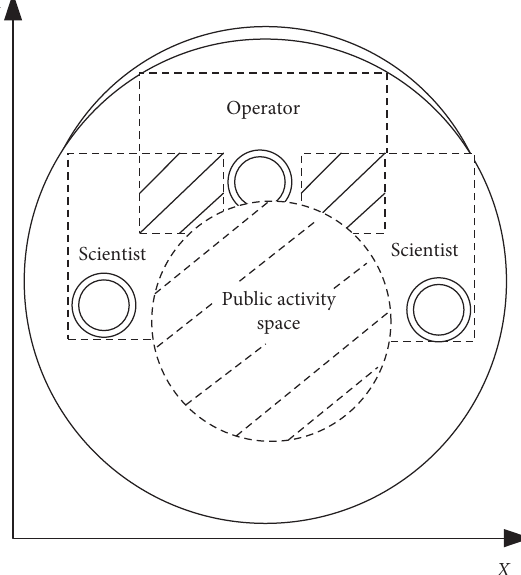
Figure 5: Reconstruction optimization of overlapping working areas in manned submersible